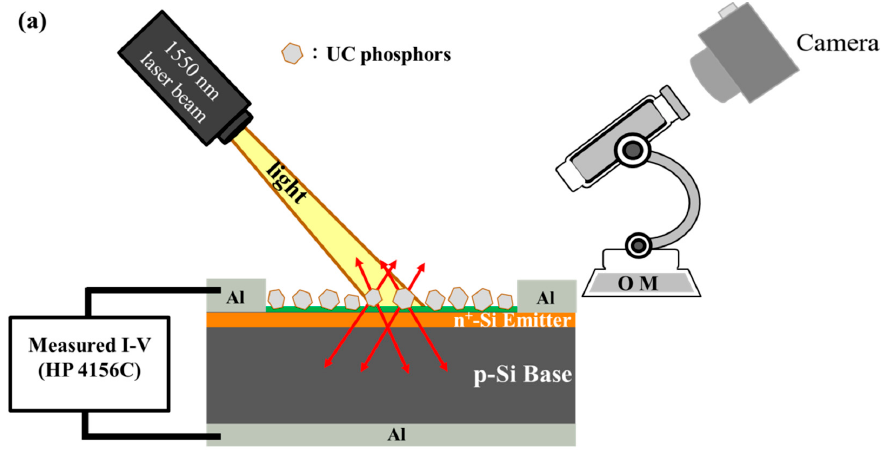
Figure 5. Photoluminescence (PL) emission spectra of SiO 2 layer containing Yb/Er-doped phosphors (YF 3 :Yb 3+ /Er 3+ ) at concentrations of 10, 20, and 30 wt%.